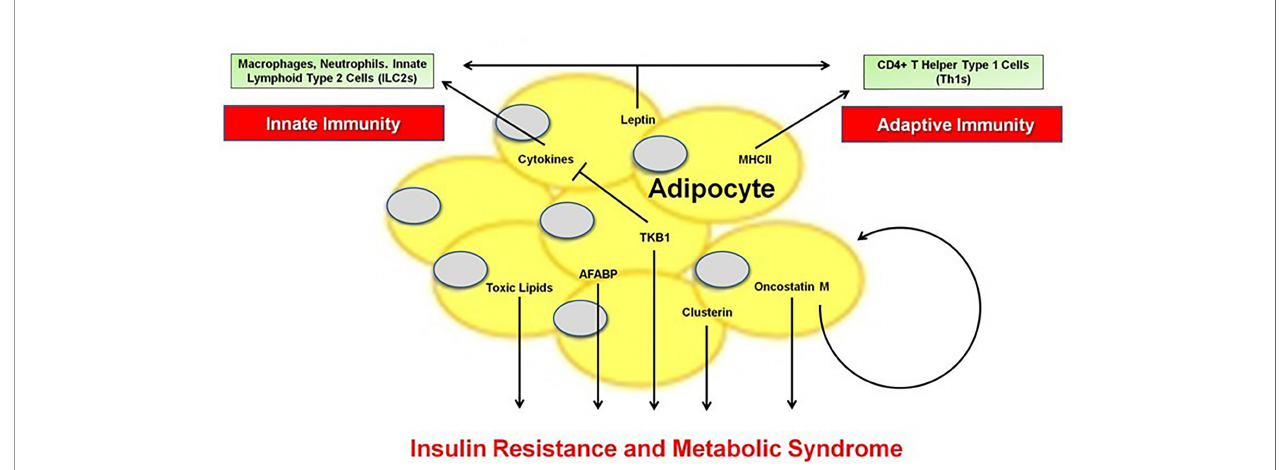
FIGURE 1 | The Innate and Adaptive Immune Functions of